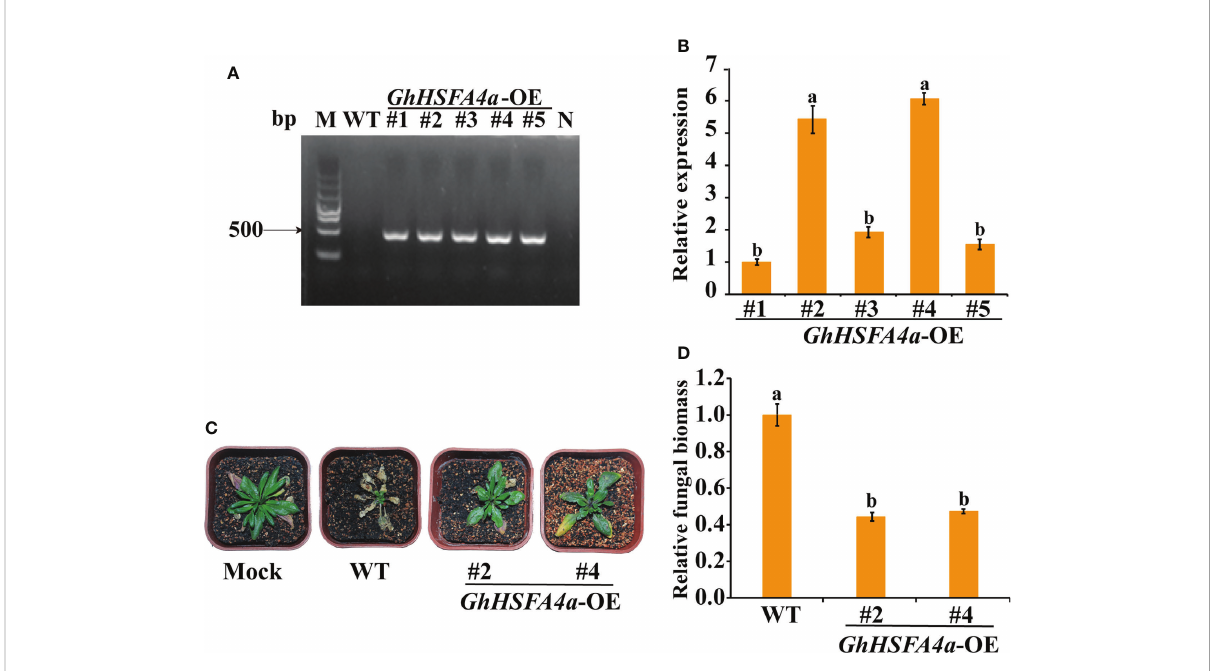
FIGURE 8 Enhanced V. dahliae resistance of Arabidopsis plants overexpressing GhHSFA4a . (A) PCR amplicons of GhHSFA4a in positive transgenic Arabidopsis . (B) Expression levels of GhHSFA4a in transgenic Arabidopsis lines (#1-#5). AtRubisco was used as an internal control. (C) Symptoms in wild-type and two GhHSFA4a -overexpressing (OE) lines of Arabidopsis plants at 21 dpi with V. dahliae. (D) Fungal biomass determined using qRT-PCR in wild-type (WT) and transgenic Arabidopsis plants. Error bars represent the standard deviations and different letters indicate signi fi cant differences at p